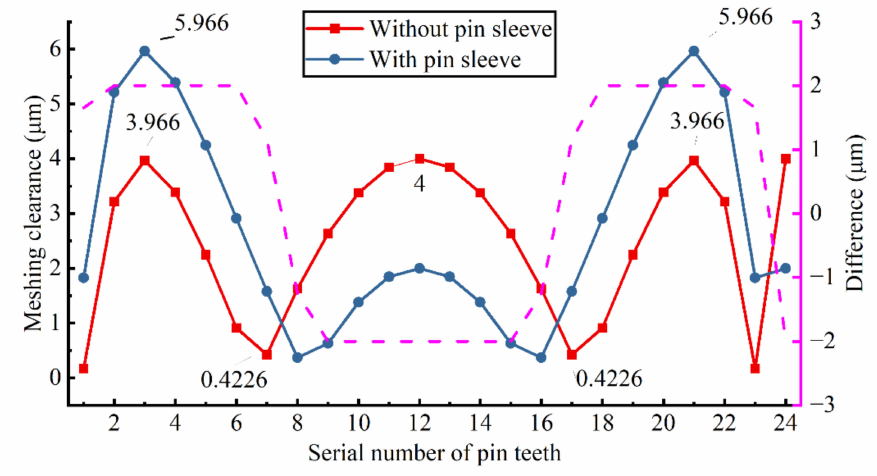
Figure 11. Pattern of meshing clearance distribution (w = 20 r/s, t = 0